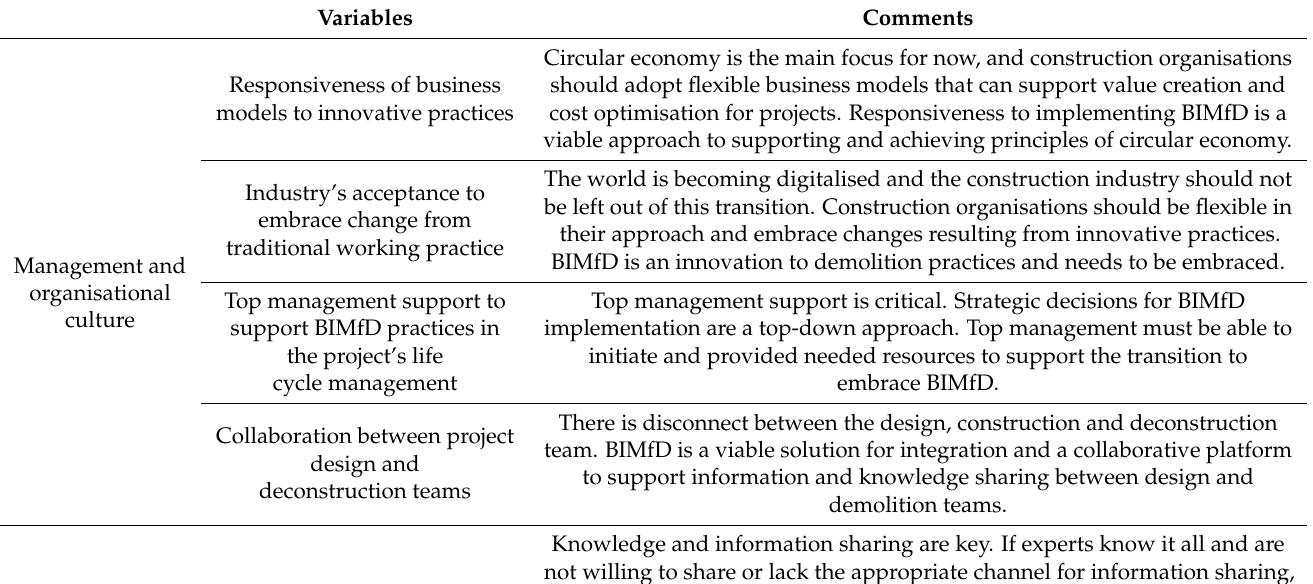
Table 7. Summary of the experts’